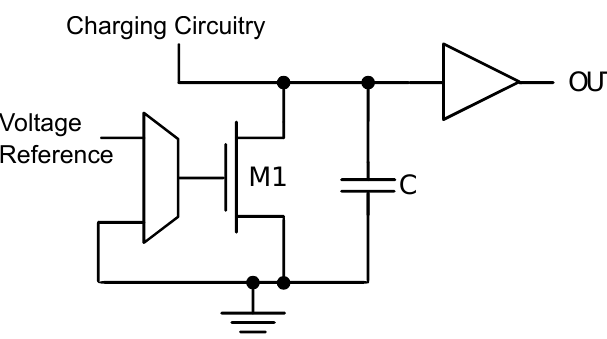
Figure 1. Constituent blocks of the 65 nm thermal